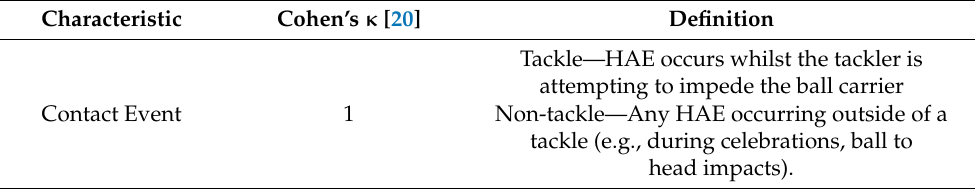
Table 1. Qualitative Video Analysis